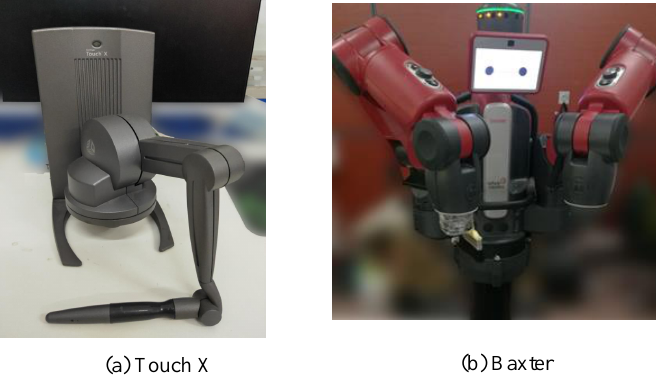
Figure 2. The master device ( a ) and slave device ( b )